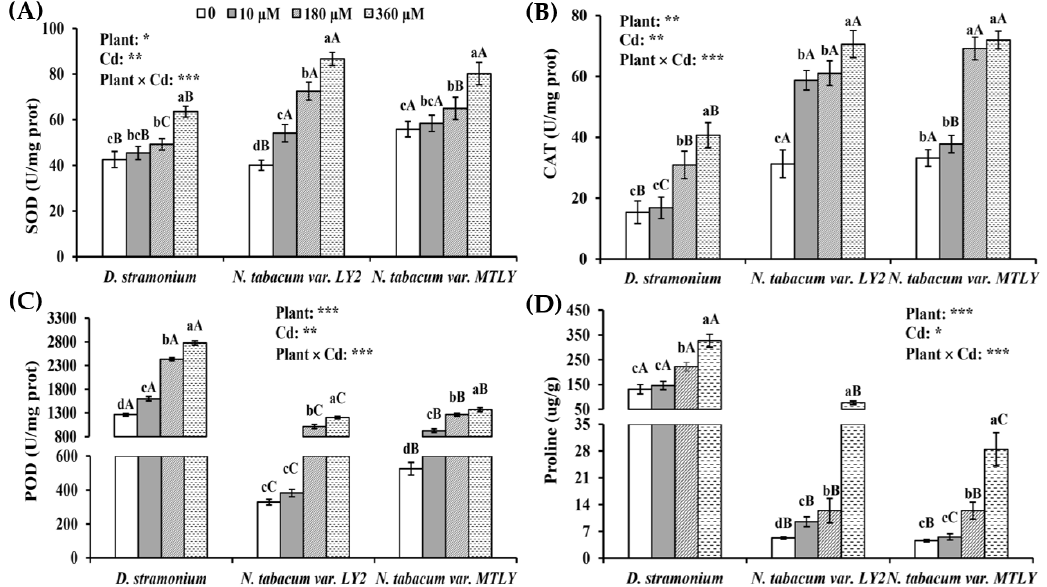
Figure 6. Antioxidant response of seedlings leaves under Cd stress. Superoxide dismutase (SOD) ( A ), catalase (CAT) ( B ) and peroxidase (POD) ( C ) activities. Proline contents ( D ). Values were expressed as means ± SD ( n = 9). Di ff erent lowercase le tt ers on the bars indicated signi fi cant di ff erences between the same material under di ff erent Cd concentrations. Di ff erent uppercase le tt ers on the bars indicated signi fi cant di ff erences between di ff erent materials under the same Cd treatment ( p < 0.05). GLM was used to assess the e ff ects of plant materials, Cd treatments and their interactions on test results. The signi fi cance was indicated as follows: * 0.01 < p ≤ 0.05; ** 0.001 < p ≤ 0.01; *** p ≤ 0.001.